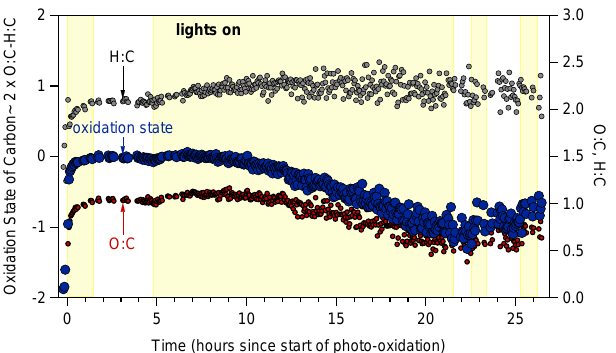
Figure 4. Organic aerosol mass yields for Expts. 7 and